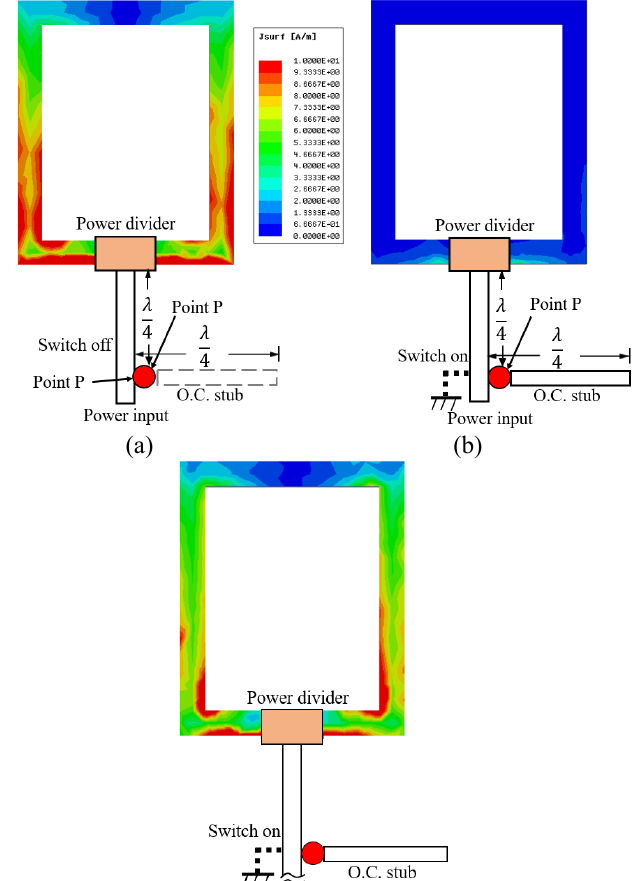
Figure 3: Conceptual drawings and simulated current distributions of (a) switch-off state, (b) switch-on state, and (c) current induced by plane wave incident for switch-on state at 2.45